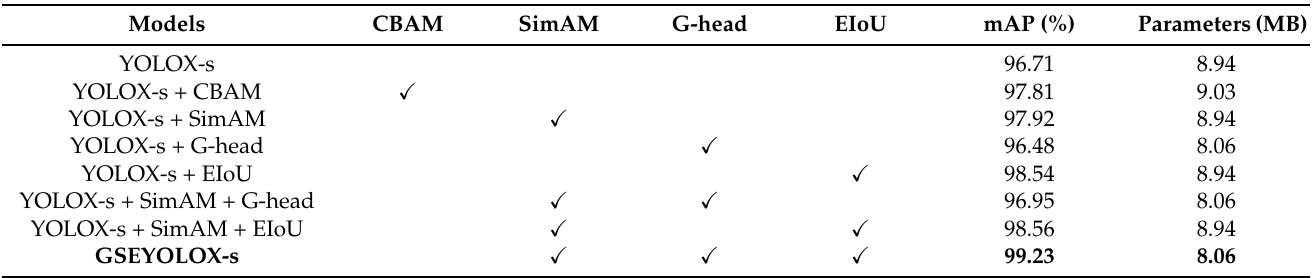
Table 3. Ablation experiments of the GSEYOLOX-s on